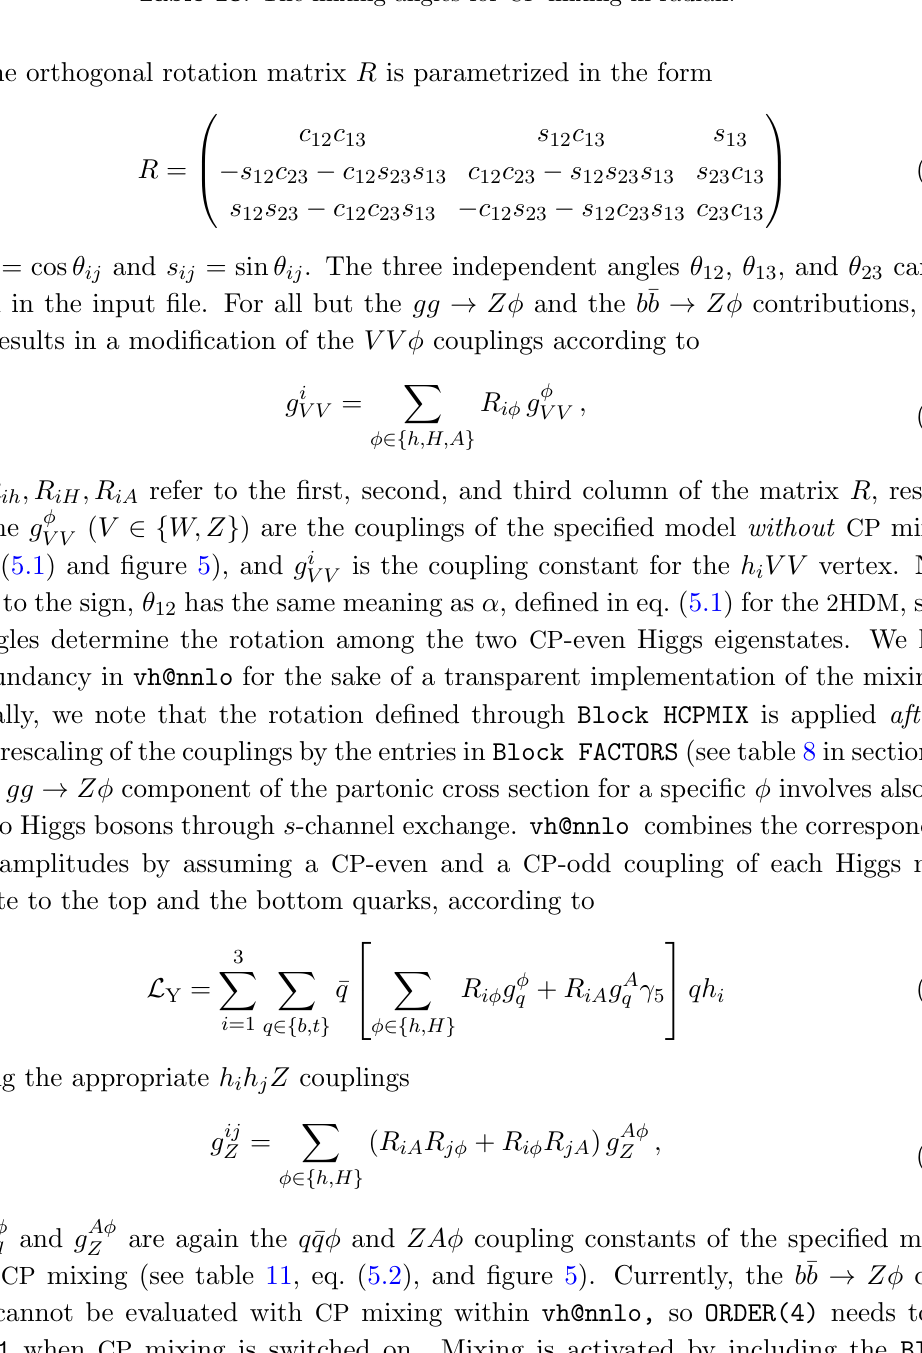
Table 18 . The mixing angles for CP mixing in